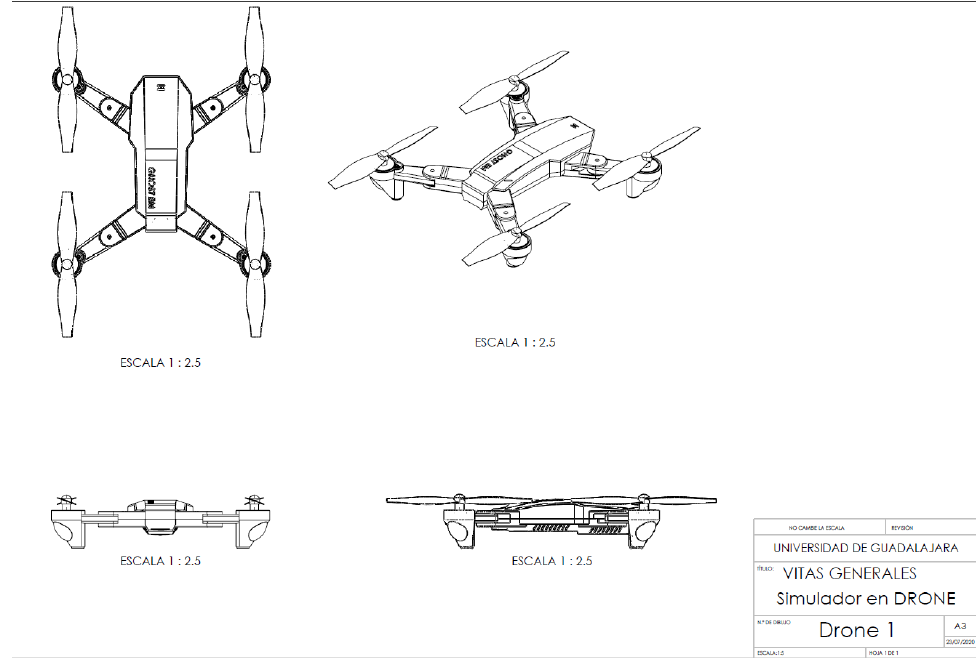
Figure 15. Isometric view with details.